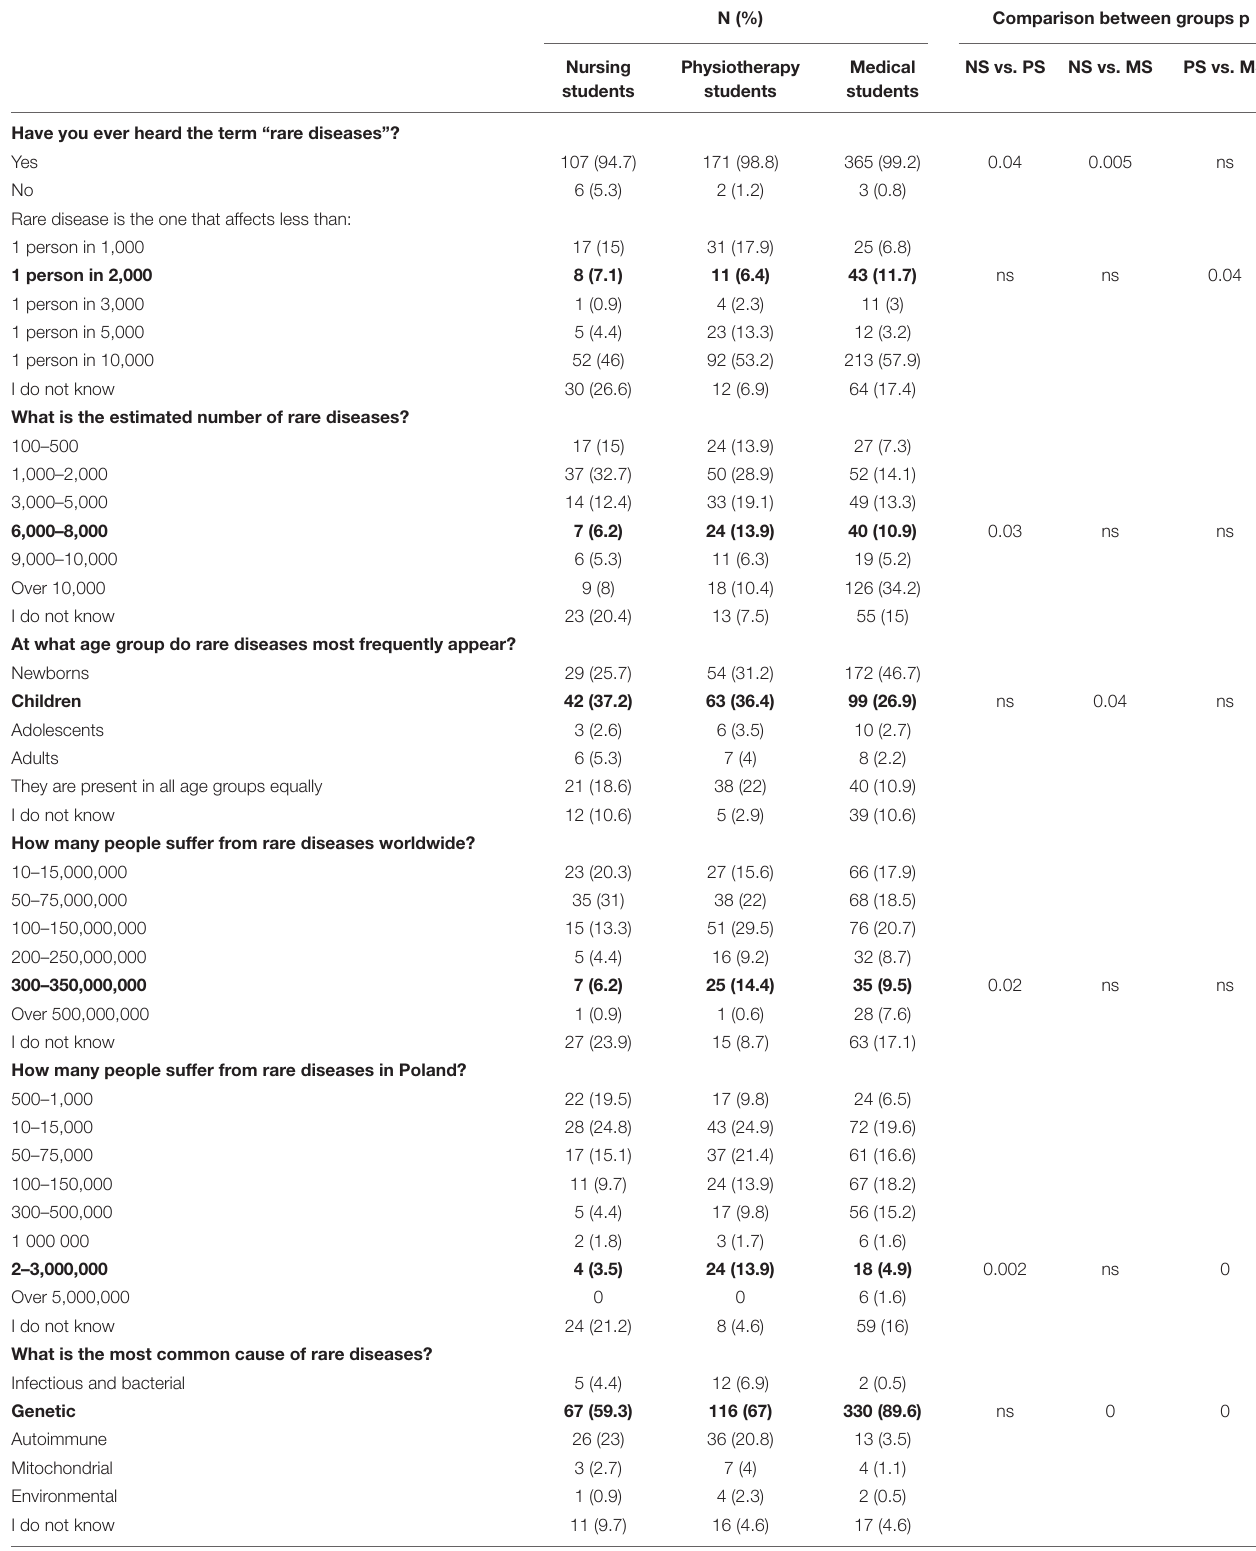
TABLE 2 | Students’ knowledge about rare